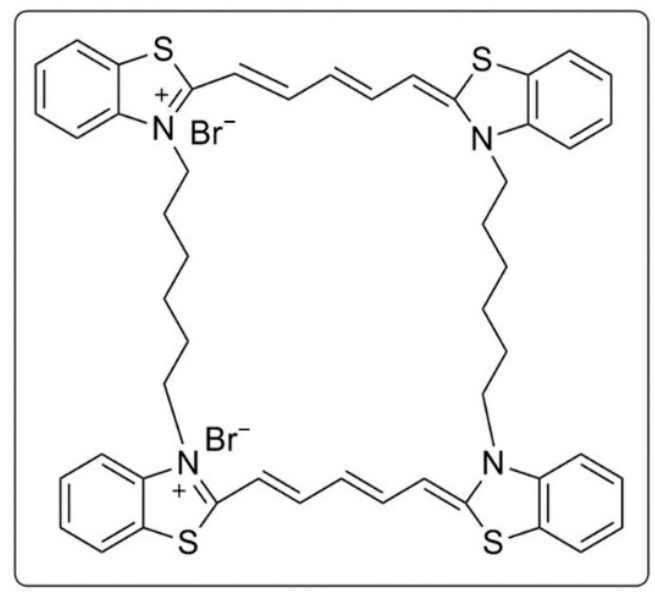
Figure 1. Structure of dimeric carbocyanine dye B6,5.